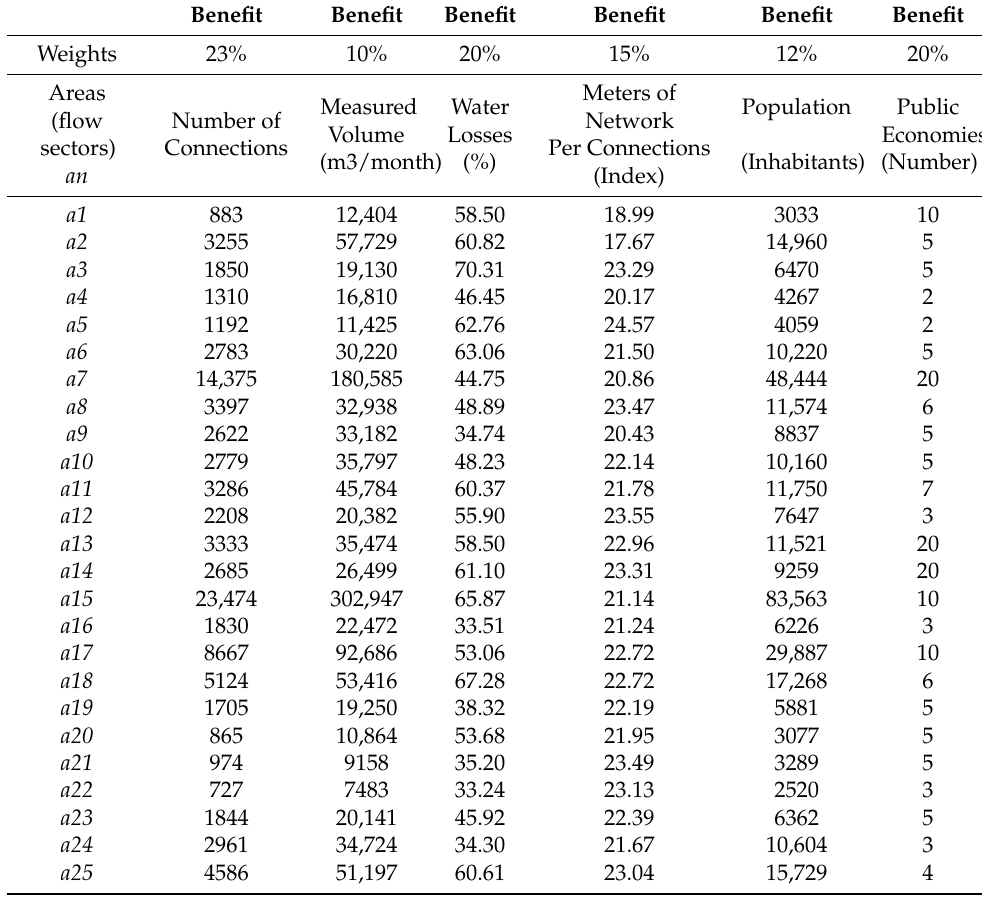
Table 7 presented the Original dataset Cost Normalized (Procedure 3), in which just the cost target for criteria 3 and 4 were normalized. The other data were considered equal to the original dataset. Table 7. Original dataset Cost Normalized—Procedure